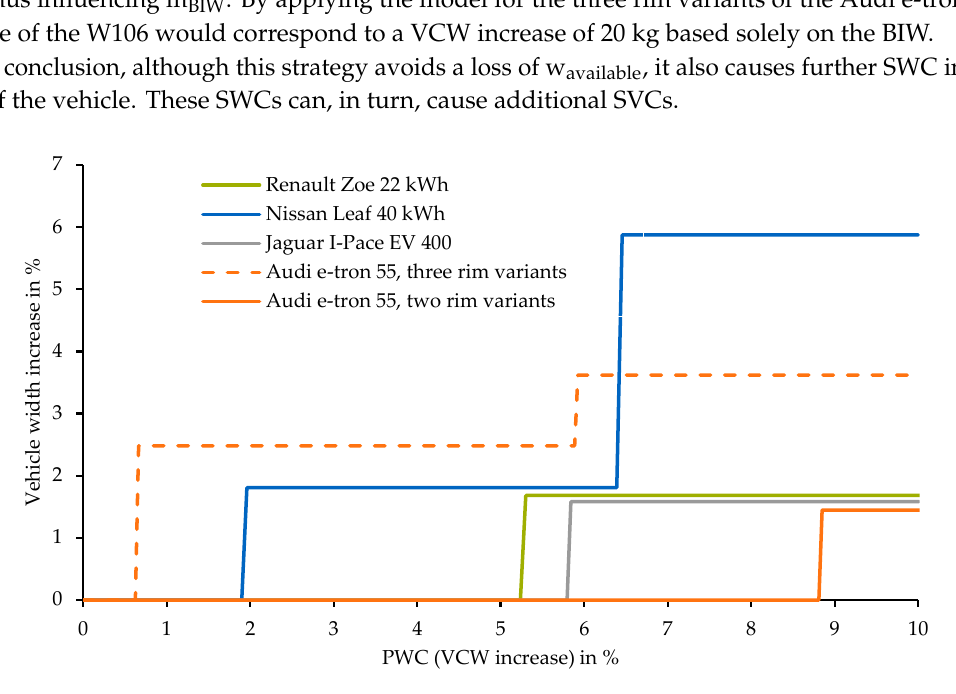
Figure 10. Interdependency between the vehicle width and the PWC.